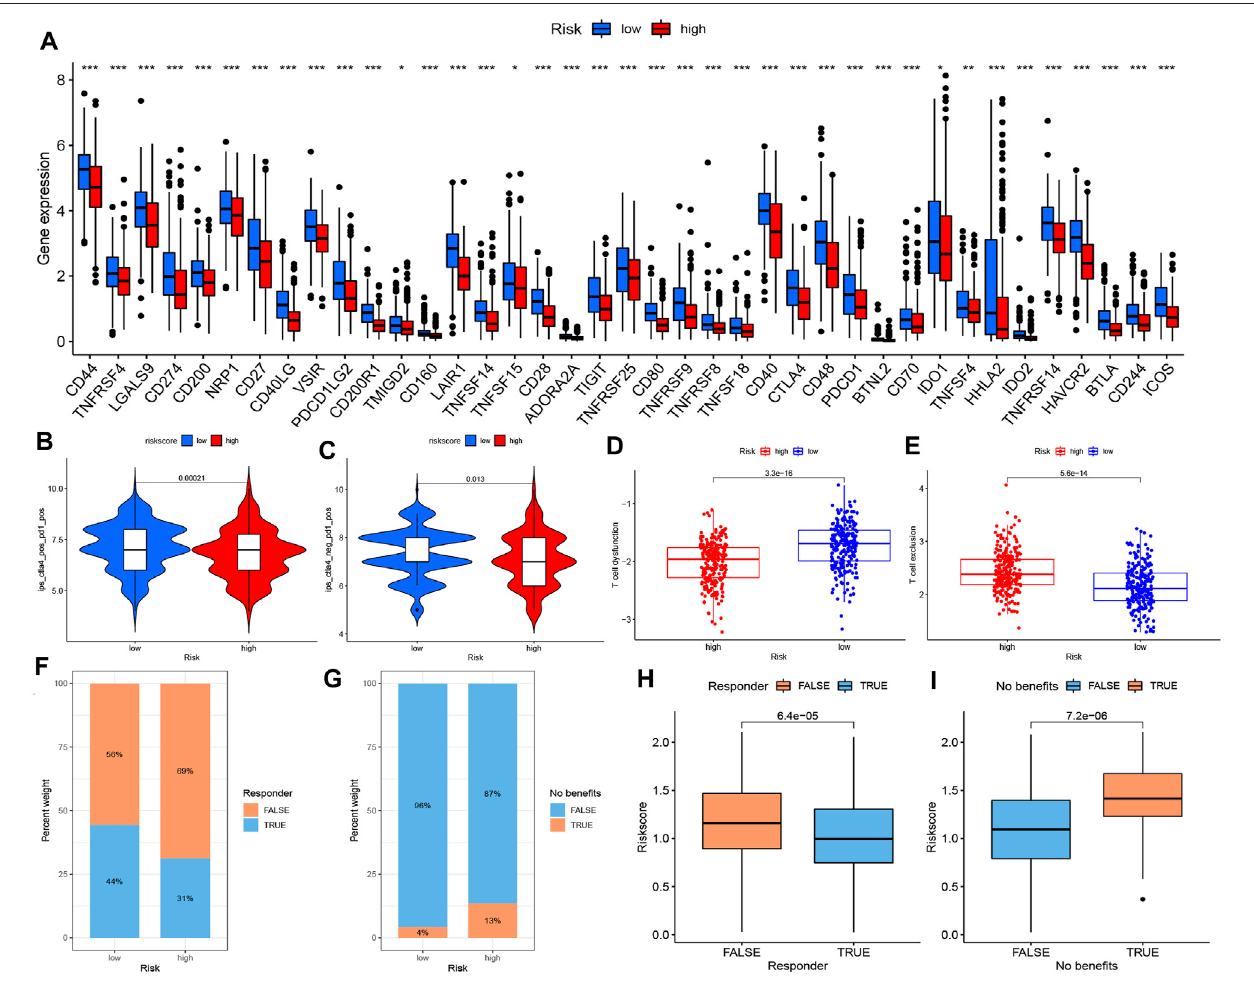
FIGURE6| Prediction ofresponse toICB therapy. (A) Theexpression ofICPs between high- and low-risk groups (Wilcox test, * p < 0.05; ** p < 0.01; *** p < 0.001). Theresponsetocombined PD1andCTLA4blockadetherapy (B) andPD1monotherapy (C) betweenhigh-andlow-riskgroups.DifferencesinTcellstatus,includingT cell dysfunction (D) and T cell exclusion (E) , in high and low risk groups. (F – I) Prediction of the “ responder ” and “ no bene fi t ” of PD1 and CTLA4 blockade therapy in TCGA- LUAD patients from TIDE website. ICB immune checkpoint blockade, ICP immune checkpoint, PD1 programmed cell death protein 1, TCGA The Cancer Genome Atlas, LUAD lung